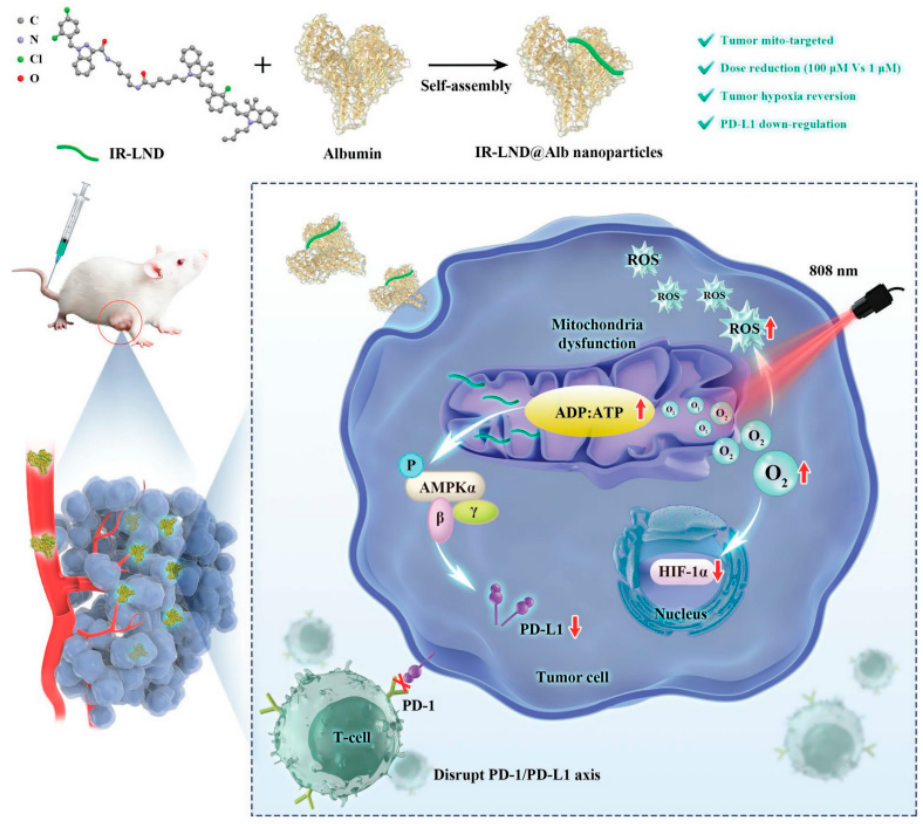
Figure 5. Combination therapy of gene therapy and PDT based on IR-LND@Alb: Nanoparticles reach mitochondria through the targeting of IR-68. LND inhibits mitochondrial oxidative phosphorylation (OXPHOS) and increases the ADP/ATP ratio. On the one hand, it can activate AMPKa channel and reduce the expression of PDL1 to prevent immune escape of tumors. On the other hand, it can alleviate the hypoxia in the tumor and generate ROS, thereby improving the photothermal efficacy of PDT and promoting the apoptosis of tumor cells. Reproduced with permission from Ref. [82], Copyright (2022) John Wiley and